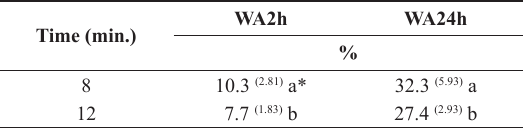
Table 5. Mean values of water absorption as a function of